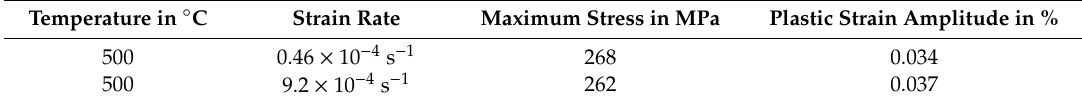
Table 2. Comparison of the Results from the First Cycles at Different Strain Rates.